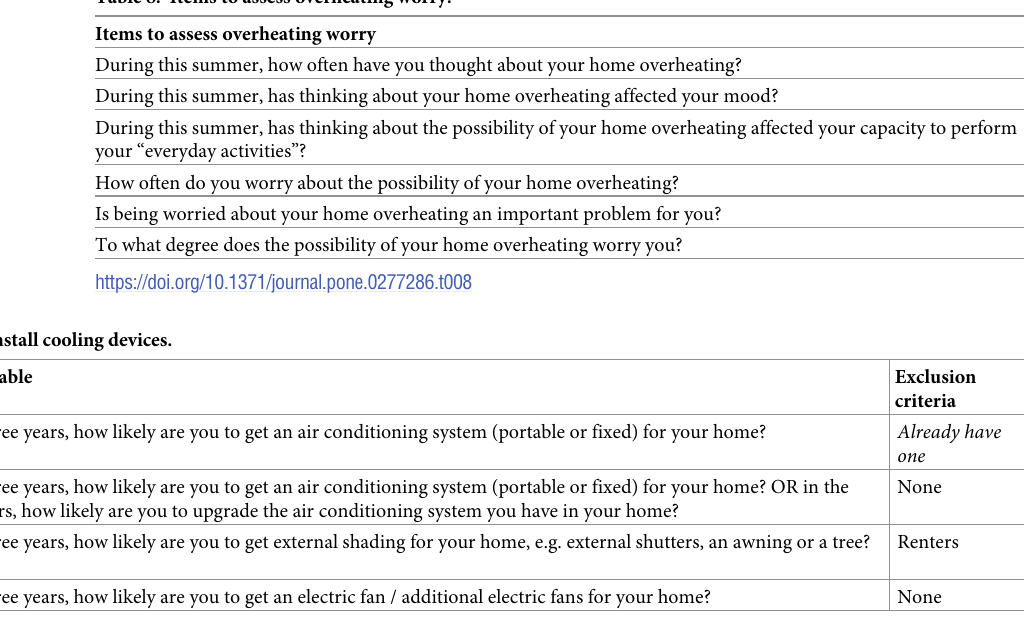
Table 8. Items to assess overheating